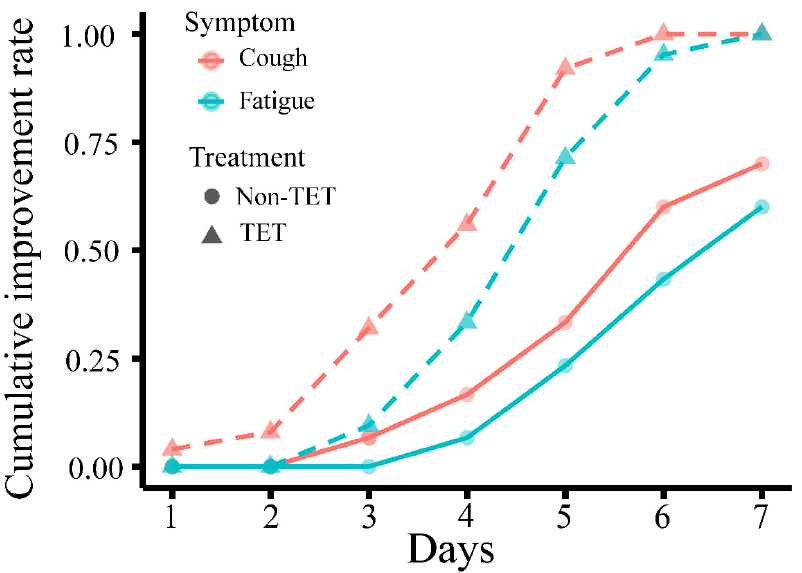
Figure 3. Cumulative day 7 improvement rate of cough and fatigue in COVID-19 patients with and without tetrandrine treatment. The line for cough is orange, and the line for fatigue is green. TET, tetrandrine.